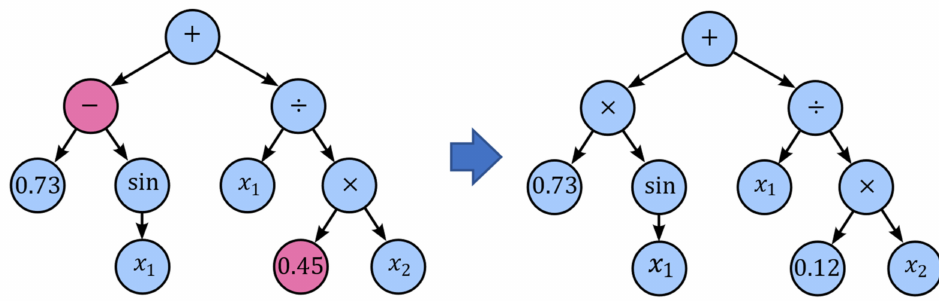
Figure 11. Point